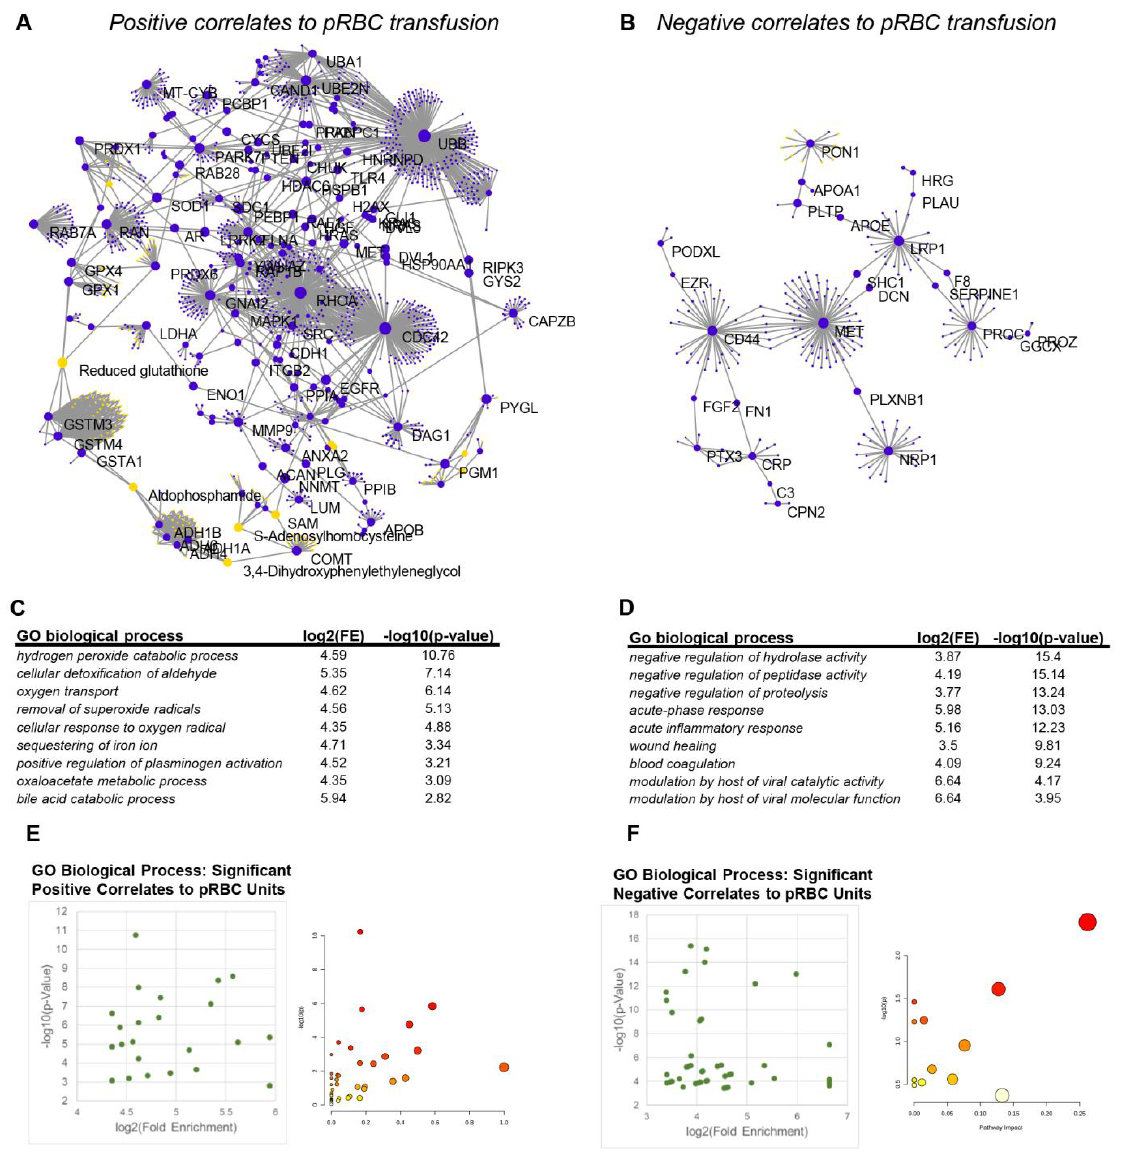
Figure 8. Integrated pathway analysis of metabolomics and proteomics data identifies pathways that are positively and negatively impacted by pRBC transfusion. In ( A , B ), network analysis of combined metabolomics and proteomics data that positively or negatively correlate to pRBC transfusion, respectively. In ( C , D ), pathway analyses of the significant positive and negative correlates to pRBCs in COMBAT. In ( E , F ), score plots of the pathways enriched in the analyses in ( C , D ).